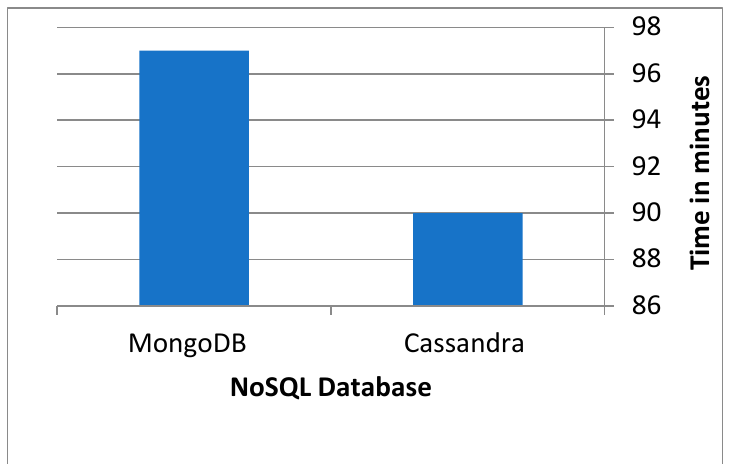
Figure 14. Migrating data using the proposed layer to Cassandra and MongoDB on the Stack Exchange dataset.